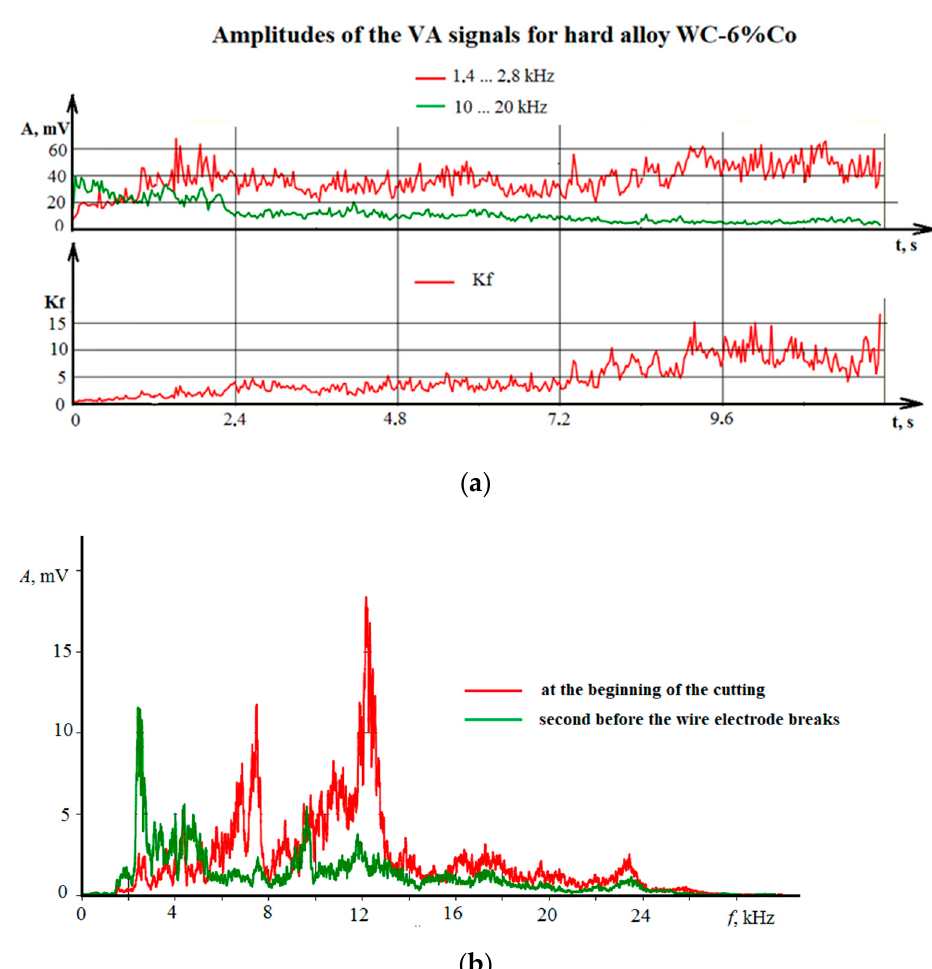
Figure 19. ( a ) RMS records of the amplitudes of the VA signals for aluminum plate; ( b ) VA spectra at the beginning of the cutting and a second before the wire electrode breaks.